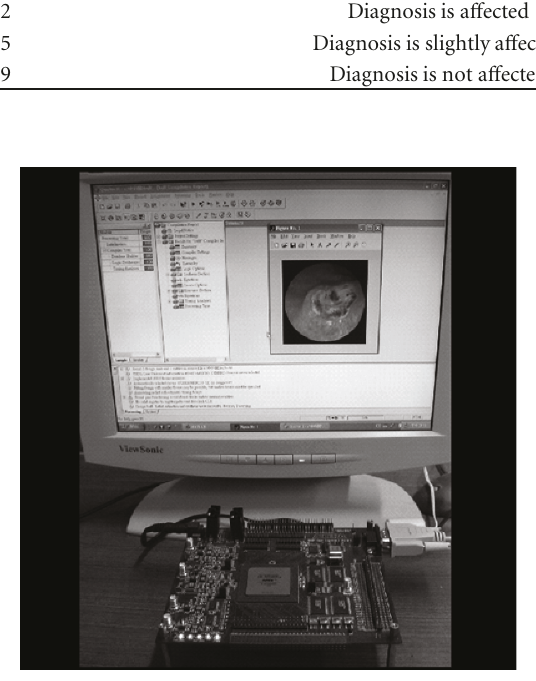
Figure 15: The FPGA prototype of the GICam-II image compres- sor. Table 6: The comparison result with previous GICam works.